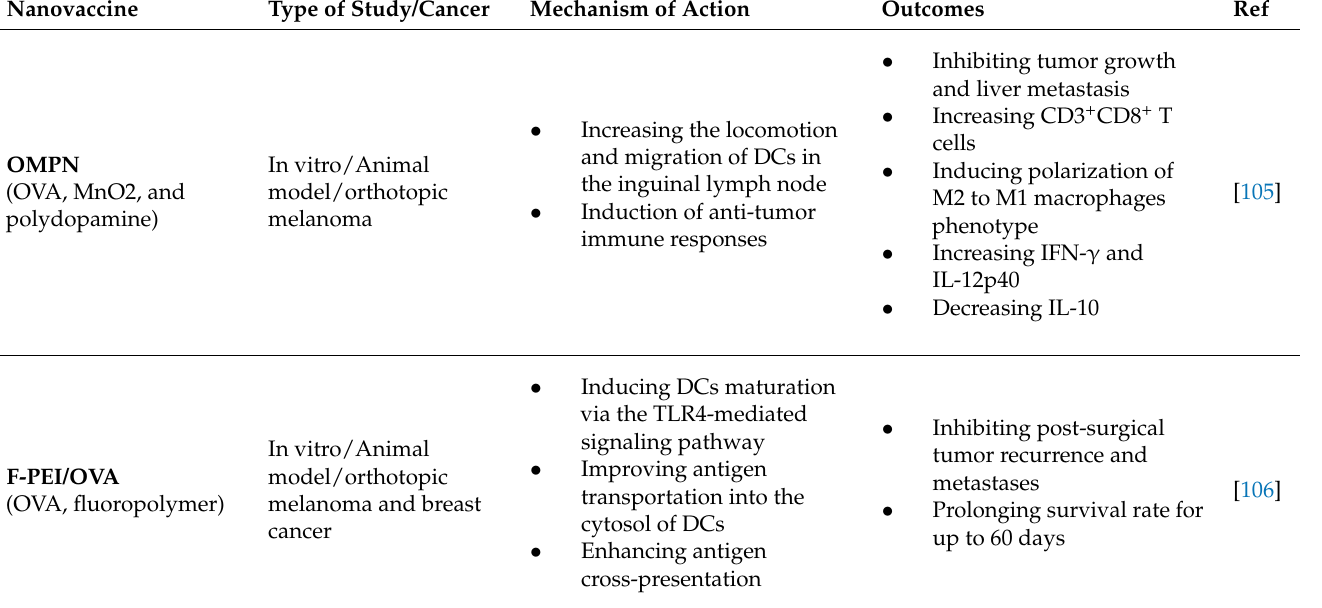
Table 1. The latest nanovaccines in cancer